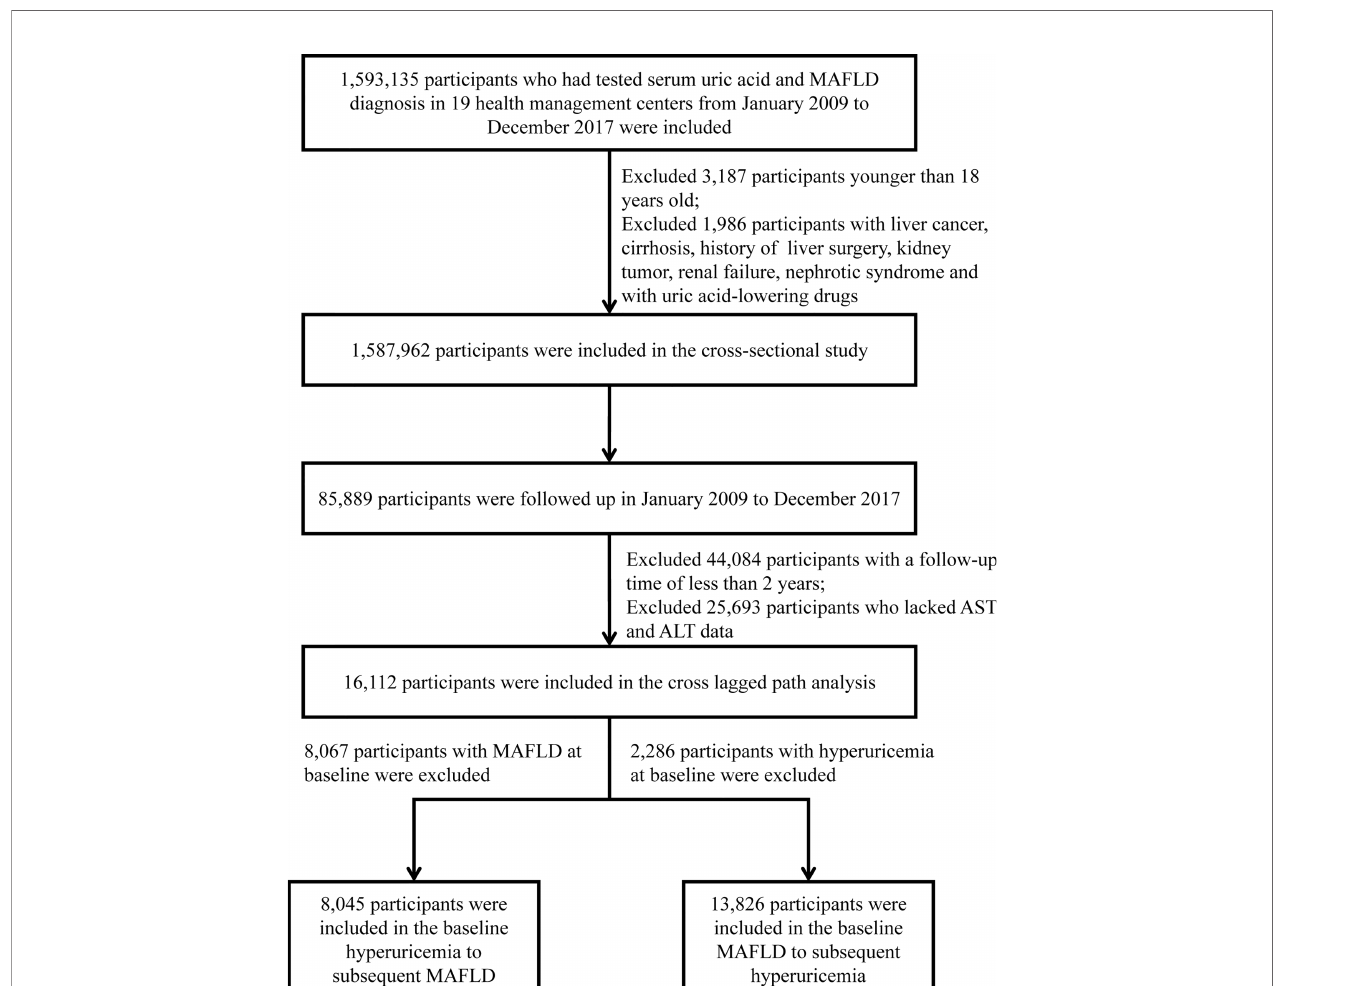
FIGURE 1 | The fl ow chart of the participants ’ enrollment. MAFLD, metabolic dysfunction-associated fatty liver disease; AST, aspartate aminotransferase; ALT, alanine